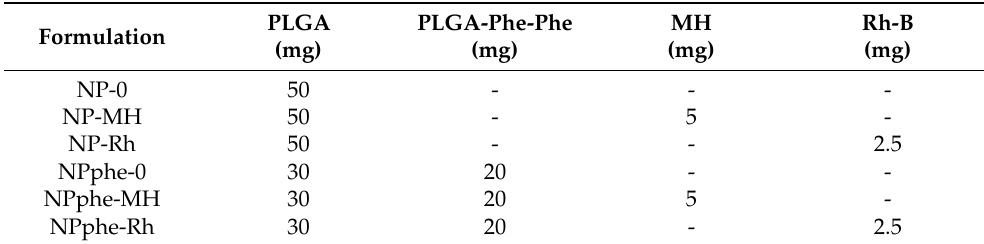
Table 1. Nanoparticle (NPs) formulations developed. phe: phenylalanine; MH: morin hydrate; Rh-B: rhodamine